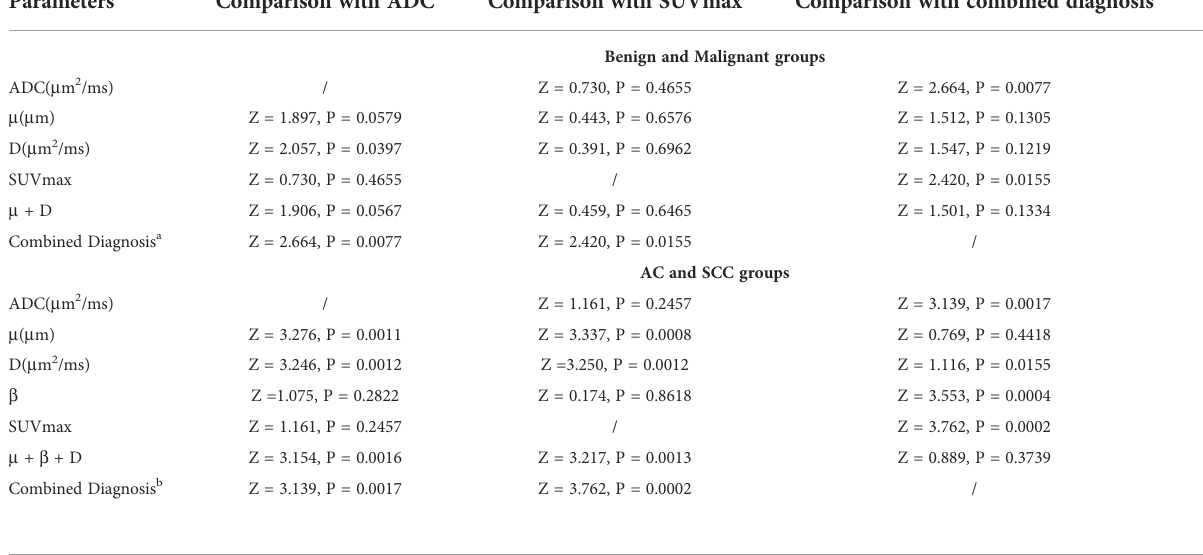
TABLE 6 The P value of ROC curve pairwise comparison of different parameters and different methods in the malignant and benign SPLs groups, and AC and SCC groups. Parameters Comparison with ADC Comparison with SUVmax Comparison with combined diagnosis Benign and Malignant groups